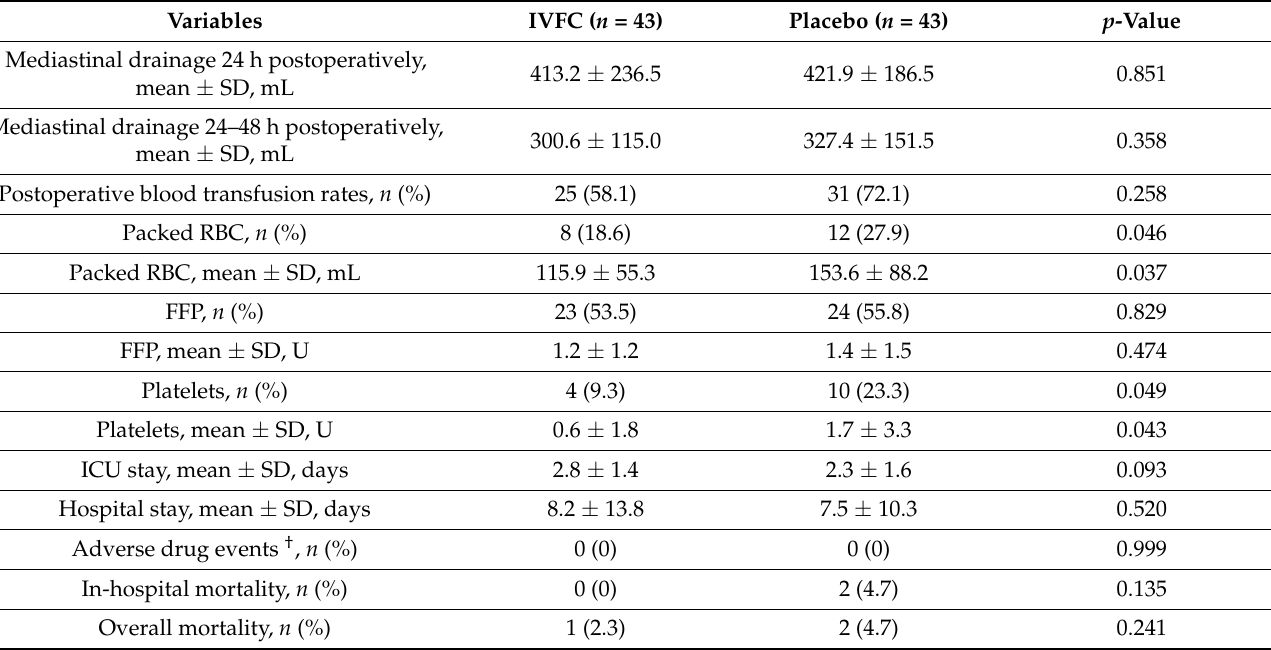
Table 3. Early clinical